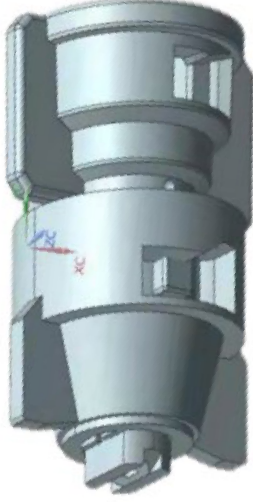
Figure 6. TD-ST type AIN model.